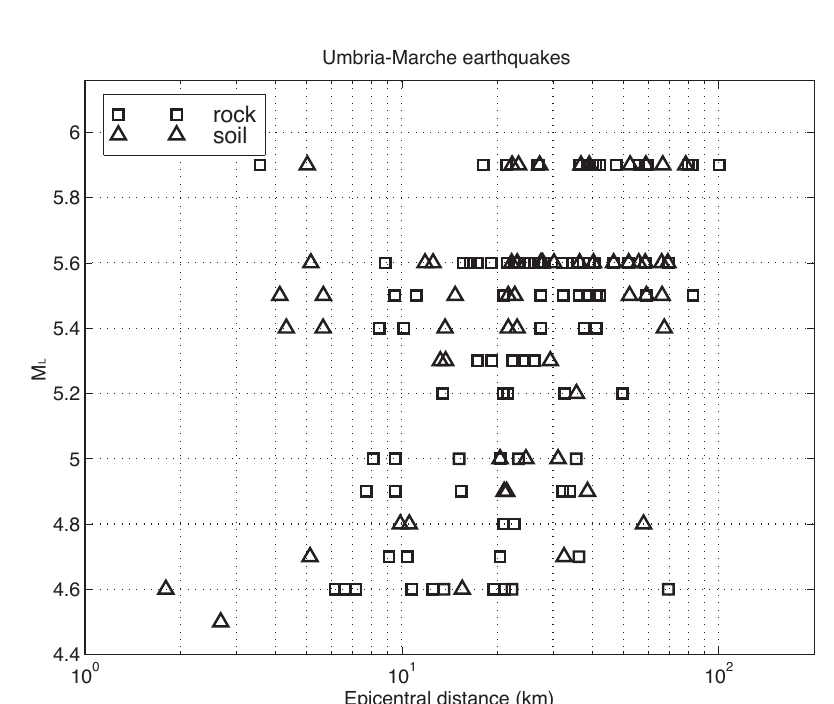
Fig. 2. Distribution of the records used in this study with respect to local magnitude M (km) and site